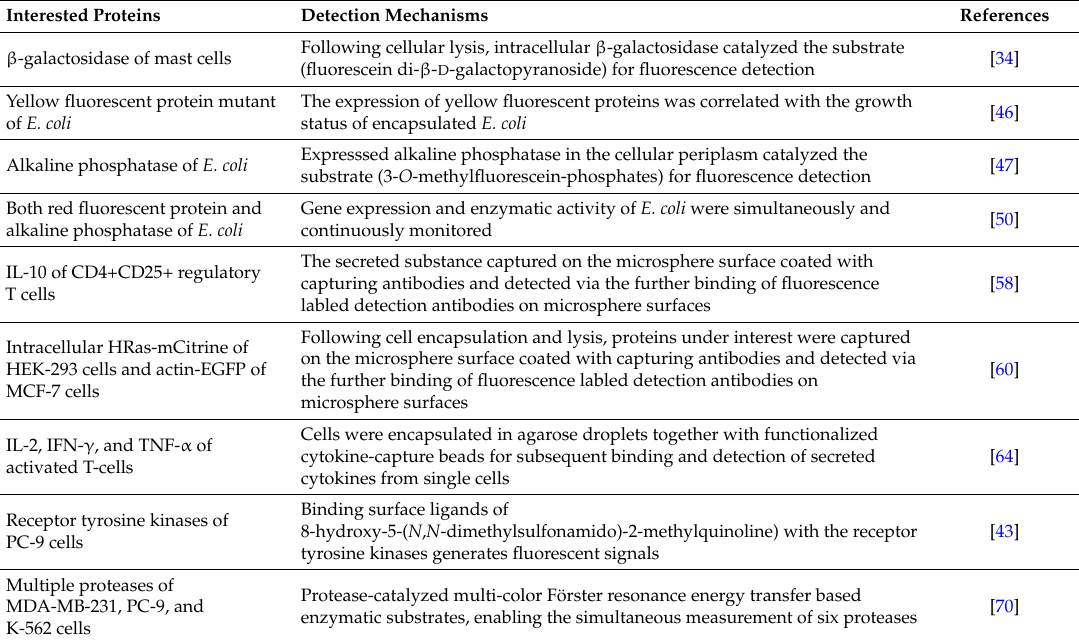
microsphere surfaces. Reproduction with permission from [58]. Table 1. Key developments of microfluidic droplets enabling single-cell proteomic analysis.